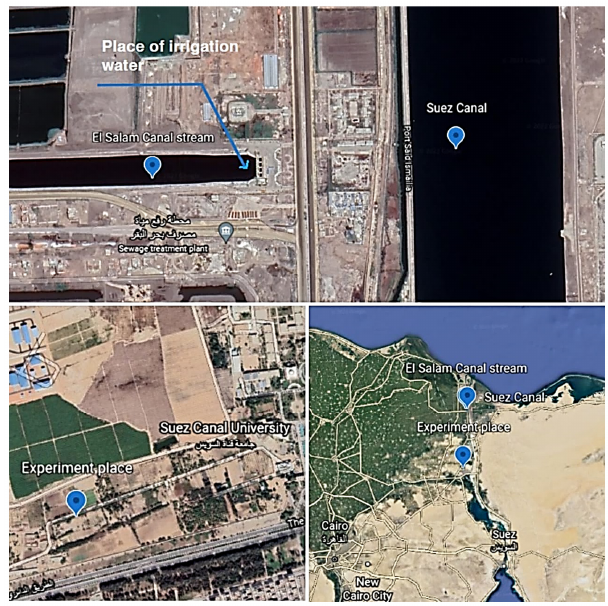
Figure 1. Location of field experiments and irrigation water source.